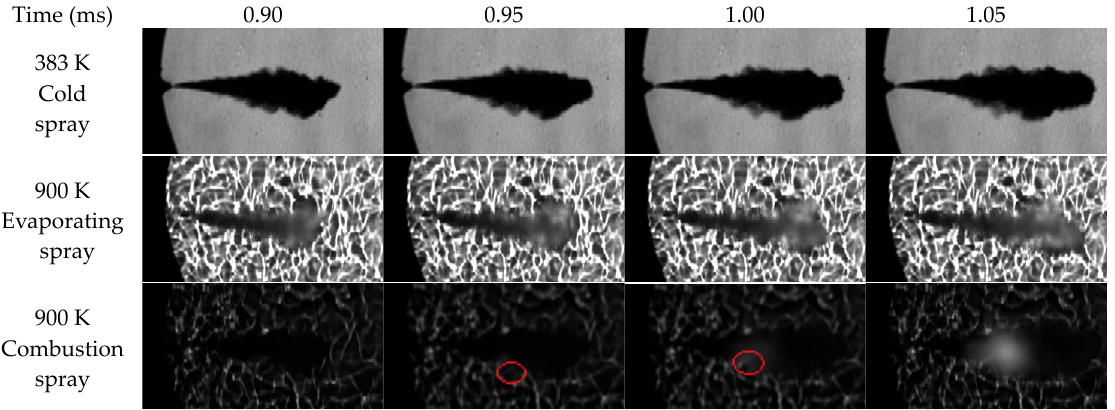
Figure 7. Demonstration of the ignition process between cold, 900 K evaporating and 900 K combustion conditions.